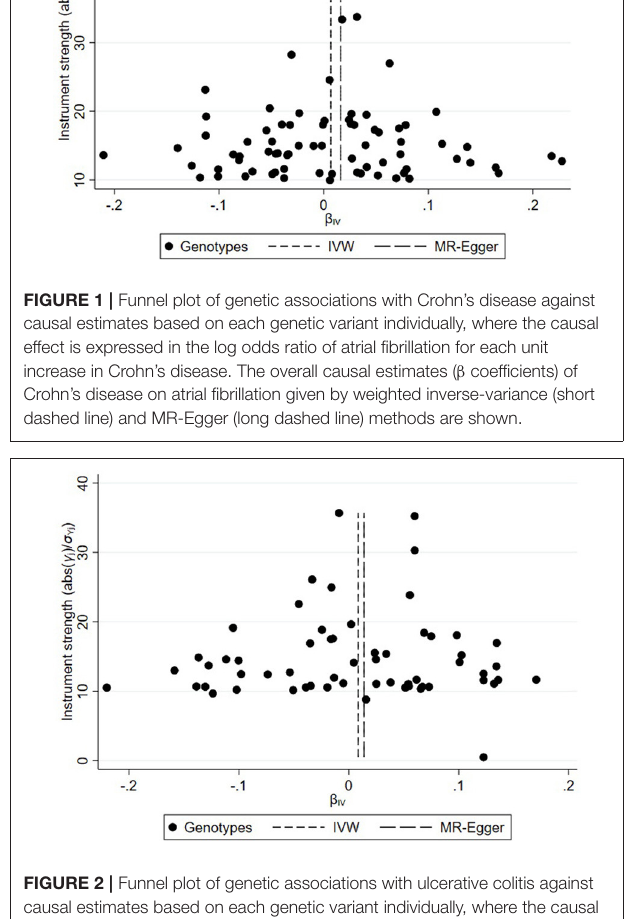
FIGURE 2 | Funnel plot of genetic associations with ulcerative colitis against causal estimates based on each genetic variant individually, where the causal effect is expressed in the log odds ratio of atrial fibrillation for each unit increase in ulcerative colitis. The overall causal estimates ( β coefficients) of ulcerative colitis on atrial fibrillation estimated by weighted inverse-variance (short dashed line) and MR-Egger (long dashed line) methods are shown.